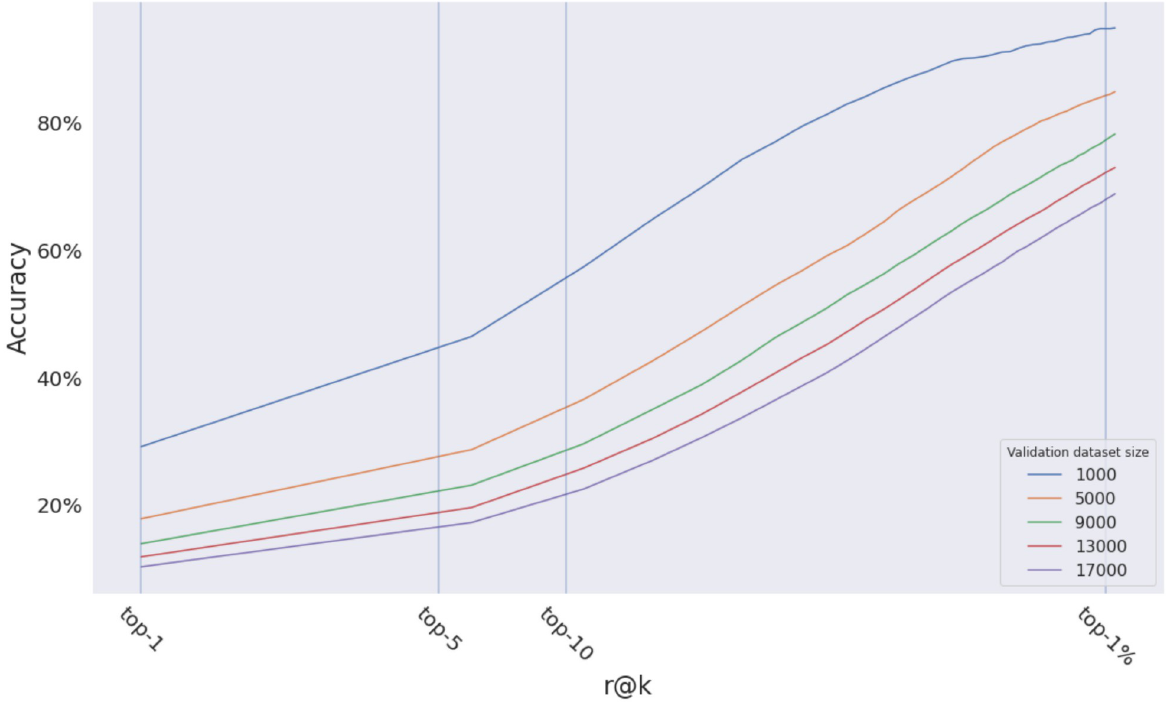
Fig 15. The effect of the size of the validation dataset on the r@ k metric. Same model (EgoTR) with the same dataset (BDD-trajectories). The accuracy decreases as the size of the validation dataset increases.